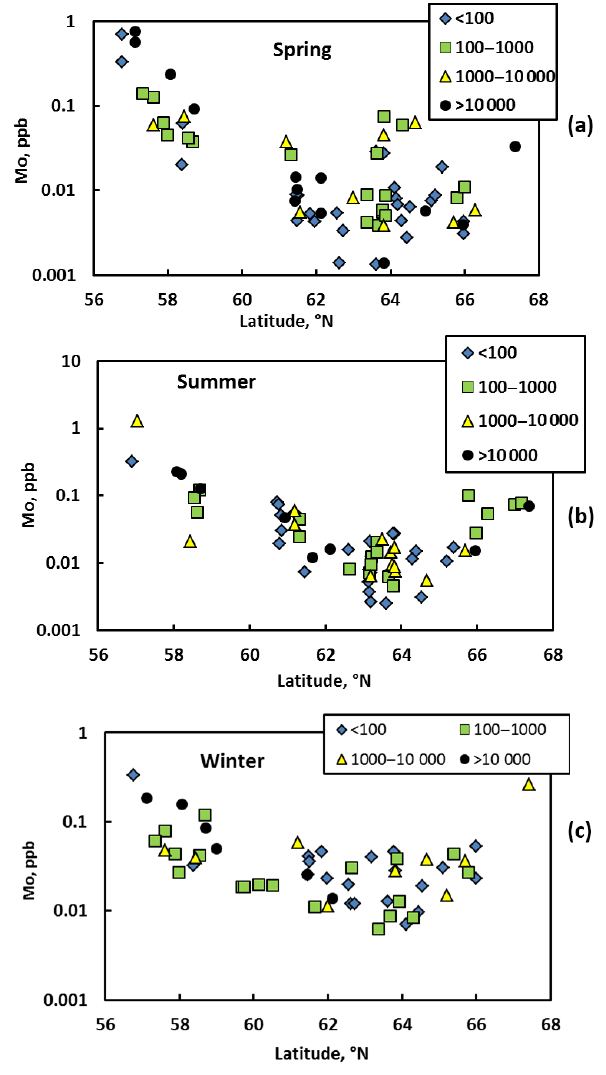
Figure 10. Variation in U concentration with latitude during spring (a) , summer (b) and winter (c) for watersheds of different size. The symbols are the same as in Fig. 2. A clear groundwater effect consists in a gradual decrease in concentration northwards, visible during all